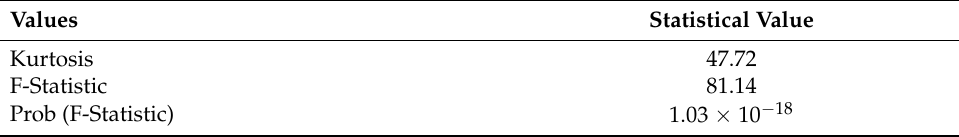
Table 7. Statistical results.